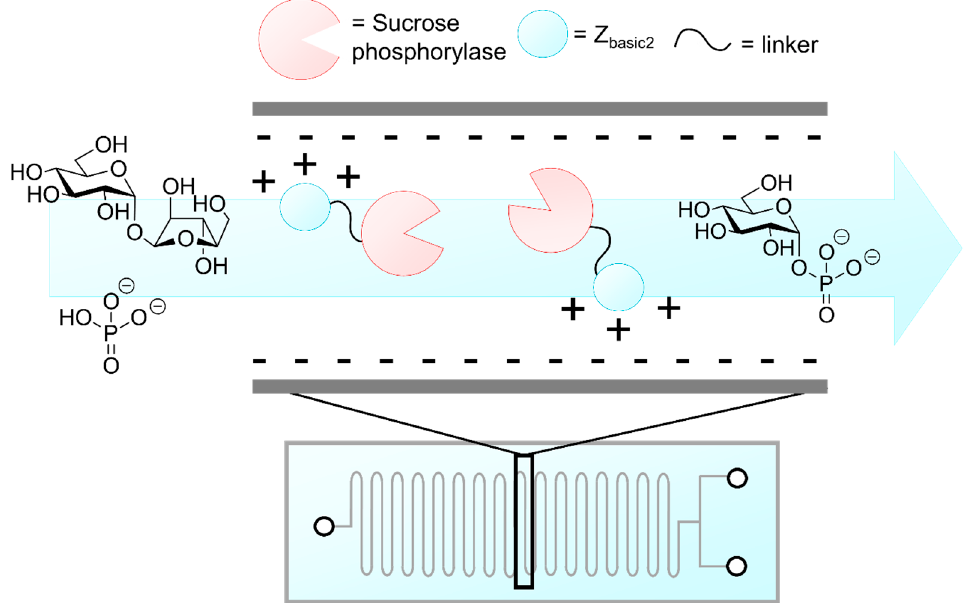
Figure 16. Glass microchannel reactor with immobilized enzyme sucrose phosphorylase attached to the siliceous wall [278]. Attachment occurs via the highly positively charged Z basic2 binding module, which binds to the negatively charged silica surface.